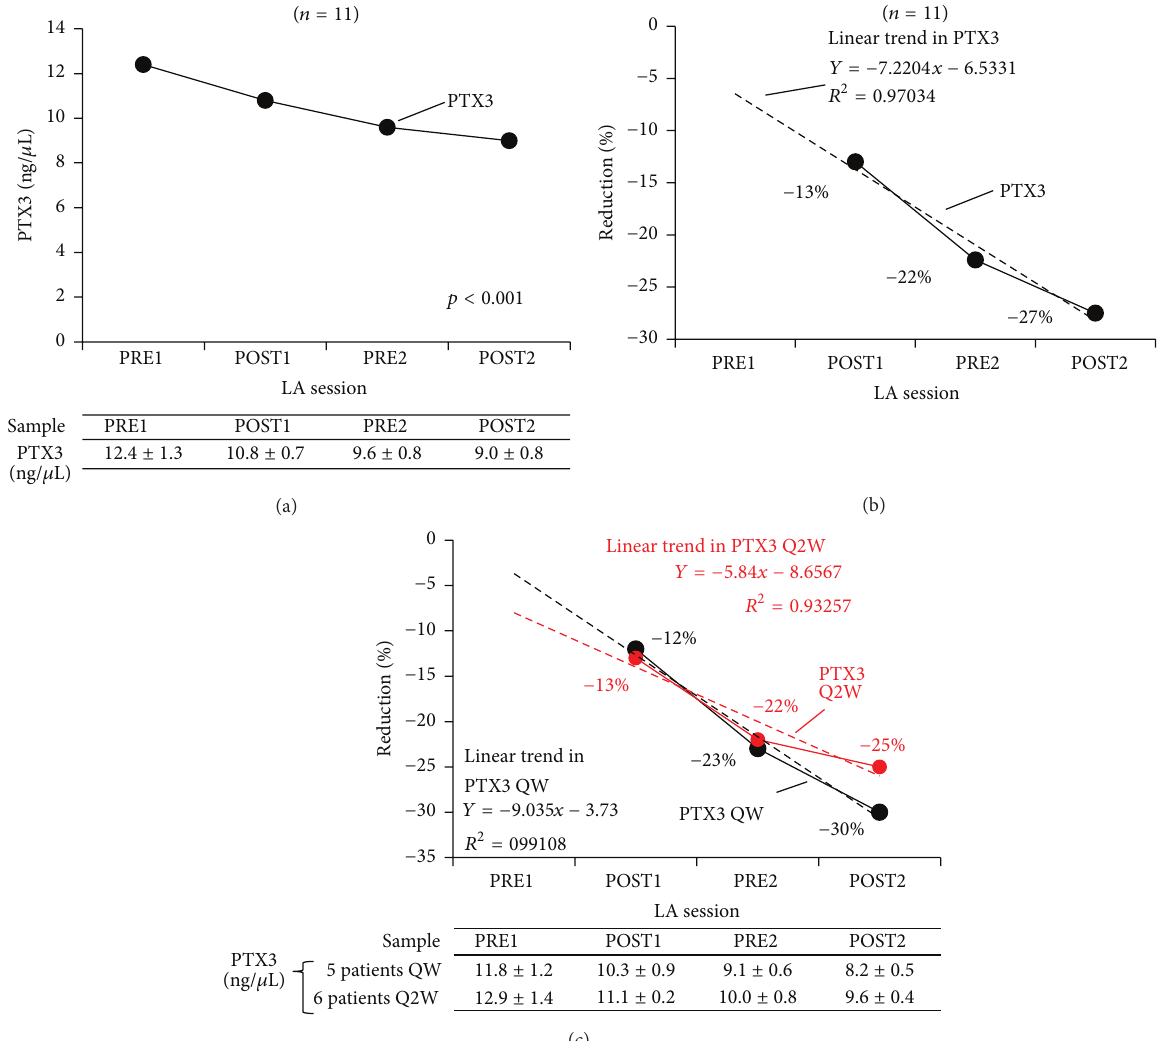
Figure 1: Effect of LA treatment on PTX3 mRNA expression (a), change in expression (b), and change in expression by LA schedule (c). LA, lipoprotein apheresis; PTX3, pentraxin 3; QW, once weekly; Q2W, biweekly; PRE1, blood sample collected before first LA session; POST1, blood sample collected after first LA session; PRE2, blood sample collected before second LA session; POST2, blood sample collected after second LA